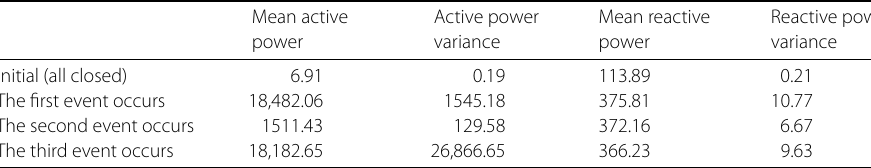
Table 4 Power load characteristics of the time period of the event